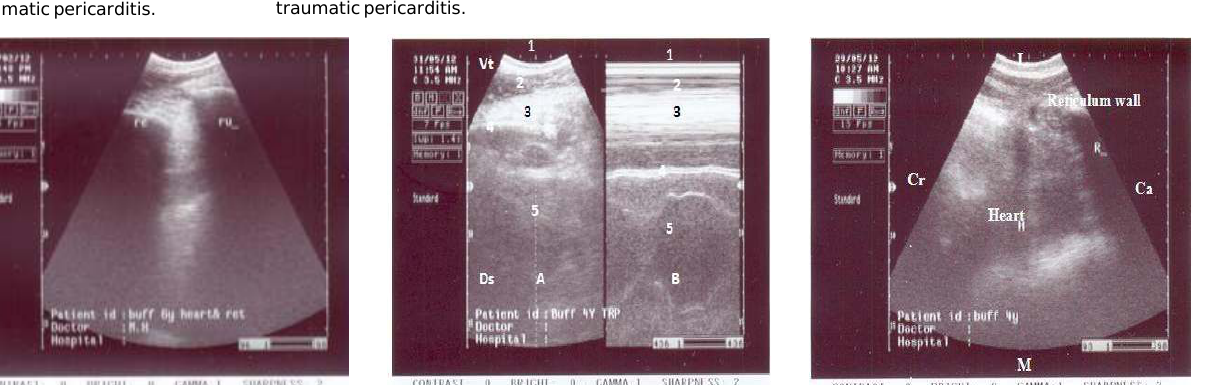
Figure-12. Lateral plain radiography of the cranial abdominal region in 7-year-old buffalo showing different types of radio-opaque metallic foreign bodies- nails (1), hair-pin (2) and non metallic foreign bodies- rocks (3) within the reticulum